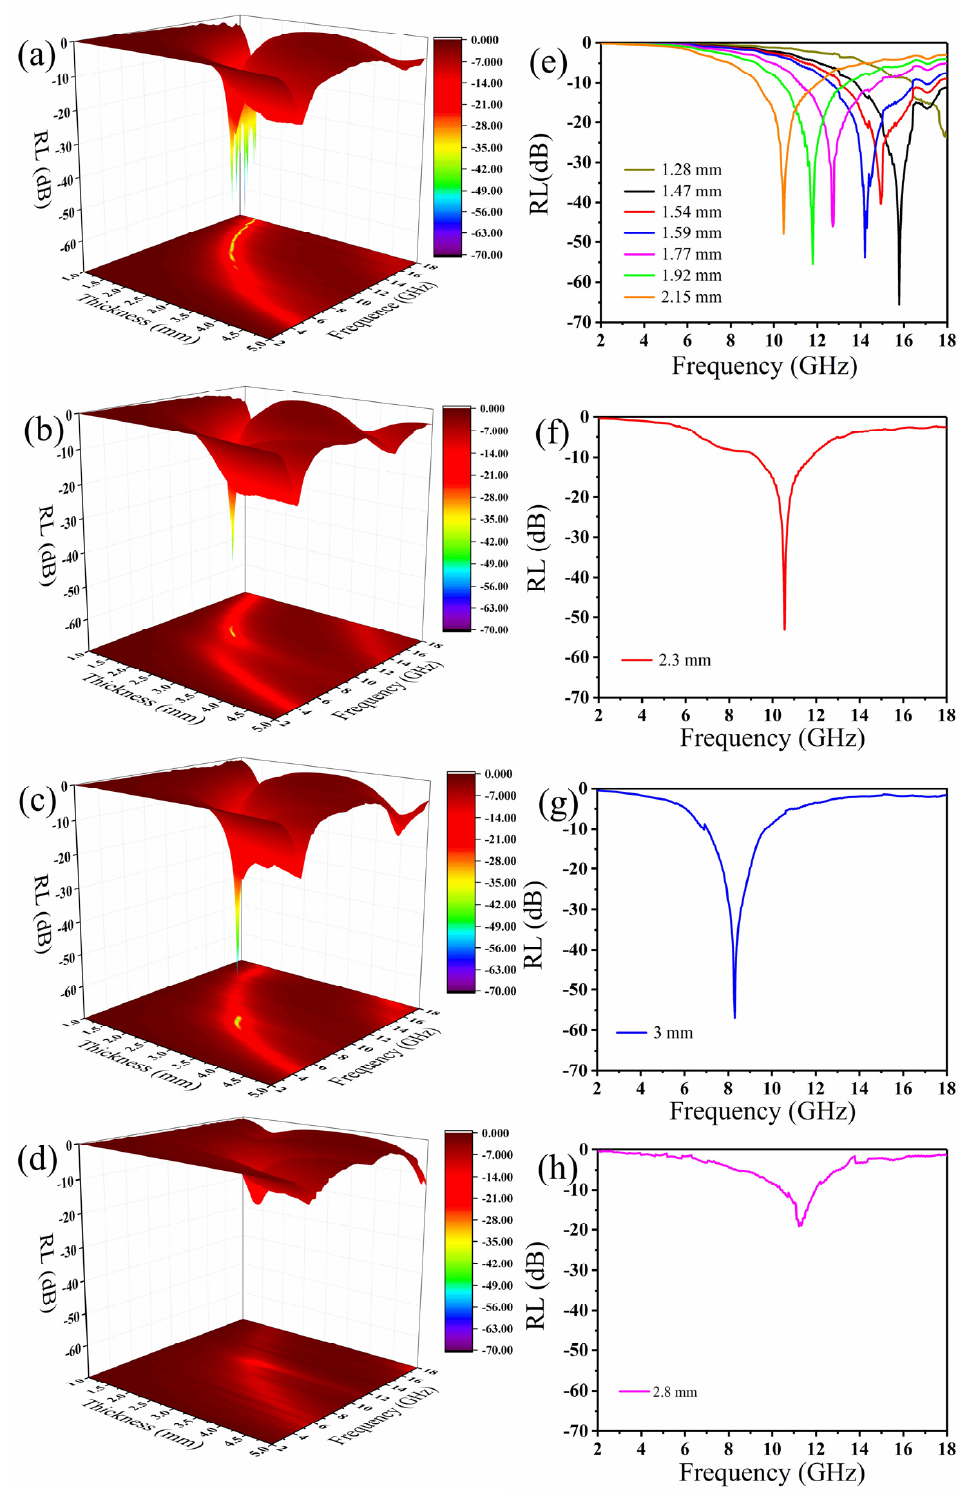
Figure 5. The 3D representation of RL values of ( a ) NC/Ni-0.25M, ( b ) NC/Ni-0.5M, ( c ) NC/Ni-0.75M and ( d ) NC/Ni-1M; The 2D representation of RL values of ( e ) NC/Ni-0.25M, ( f ) NC/Ni-0.5M, ( g ) NC/Ni-0.75M and ( h ) NC/Ni-1M at a mass loading of 50% in paraffin wax.